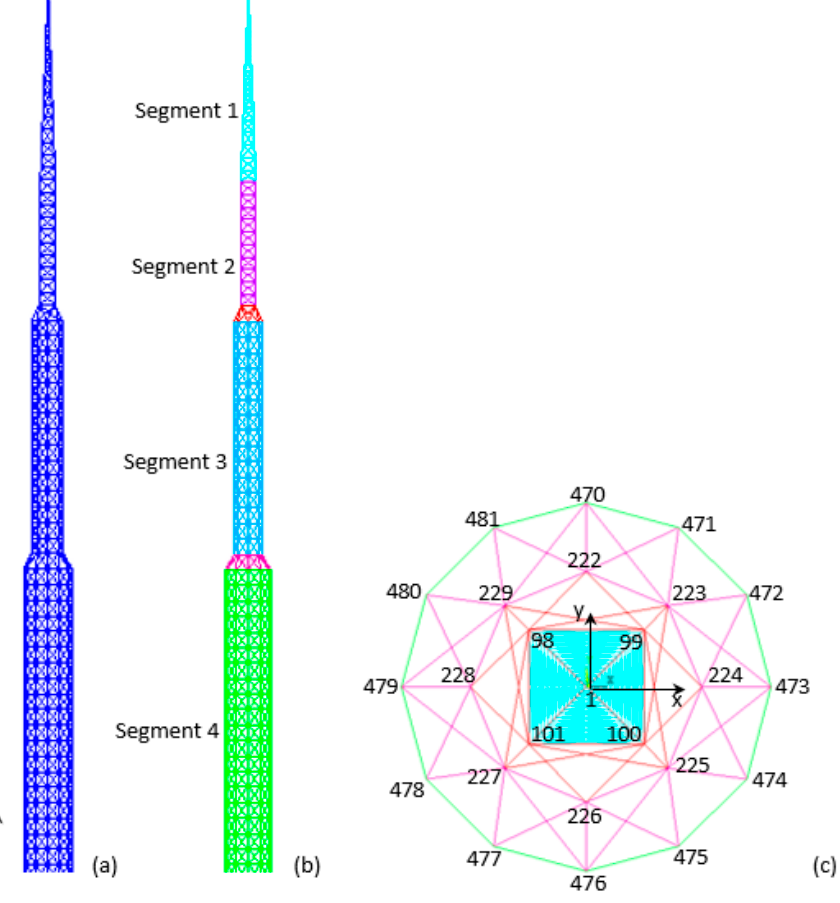
Figure 4. Schematic of the spatial 1938-bar tower: ( a ) Assembly view; ( b ) Color view of the four segments and two junction modules included in the structure; ( c ) Layout view indicating key-nodes.